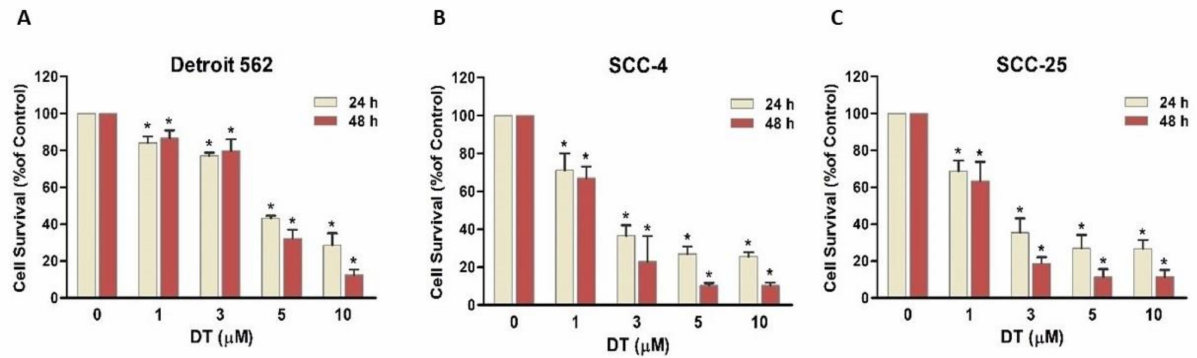
Figure 1. Dihydroisotanshinone I (DT) inhibited survival of HNSCCs cells in a dose- and time-dependent manner. The inhibitory effect of DT on ( A ) Detroit 562, ( B ) SCC-4, and ( C ) SCC-25 cells was assessed using MTT assay after 24- and 48-hours treatments with 1-, 3-, 5-, and 10- µ M DT. Data presented are the means and standard errors of the mean of three independent experiments. * indicates a statistically significant difference compared with untreated control cells of the same treatment